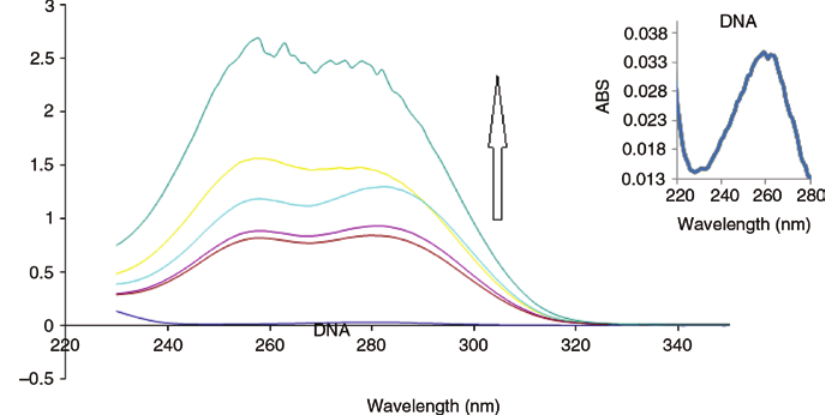
Figure 1: UV-visible spectra characteristics of STZ and their DNA adducts, with constant STZ concentration of 2.5 mm and different DNA concentrations of 0.5–2.5